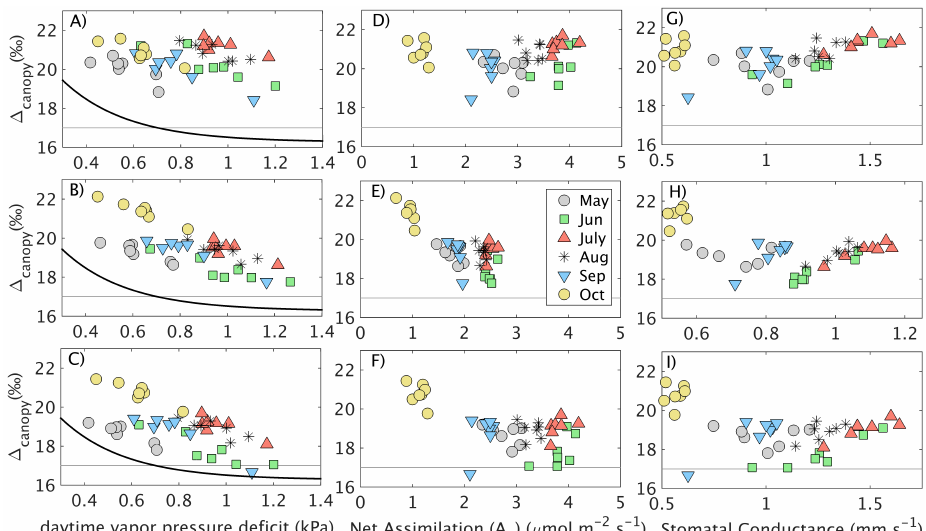
Figure 10. Relationship between monthly average photosynthetic discrimination and monthly average vapor pressure deficit (a, b, c) , A n (d, e, f) and g s (g, h, i) from 2006 to 2012. The rows represent the limited nitrogen (a, d, g) , unlimited nitrogen (b, e, h) , and no-downregulation discrimination (c, f, i) simulations. The black lines in (a) , (b) and (c) are based on an exponential fitted line from the observed relationship at Niwot Ridge (Bowling et al., 2014). The horizontal lines represent δ 13 C of 17‰ and are included for